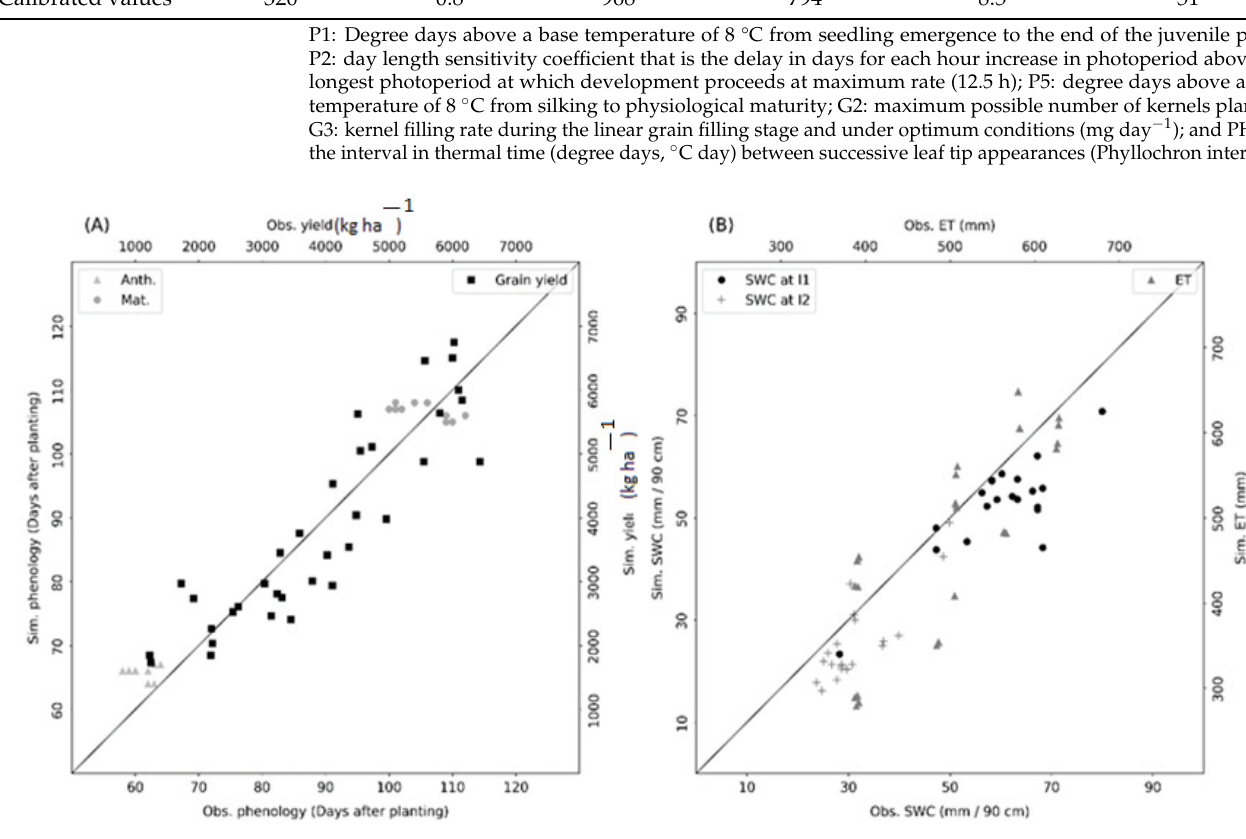
Figure 1. ( A ) Model calibration for maize phenology and grain yield and ( B ) soil moisture content and evapotranspiration using detailed experimental dataset in Ismailia, Egypt described in [17]. Irrigation treatments included high irrigation water level (I1) during the calibration process, and lower irrigation level (I2) during validation level. Automatic irrigation based on the maximum al- lowable depletion (50% MAD) was used in I1, while deficit irrigation based on 50% ET was consid- ered in I2. Table 1. Calibrated values of cultivar-specific parameters for medium-maturity maize variety (CV, SC10) in the DSSAT-CERES-Maize model (v. 4.7.5) for maize experiments in Ismailia, Egypt.